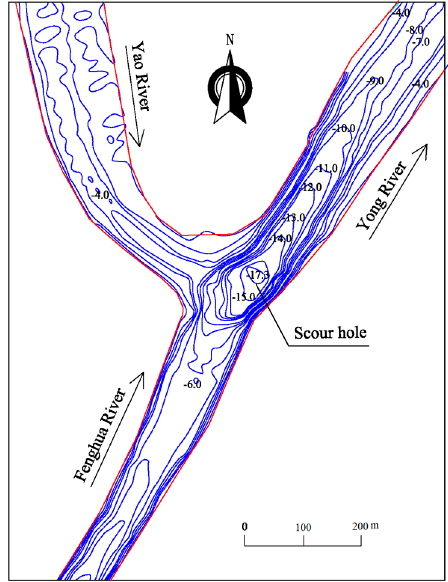
Figure 17. Contours of the confluence in June 2015 ( T = 0).